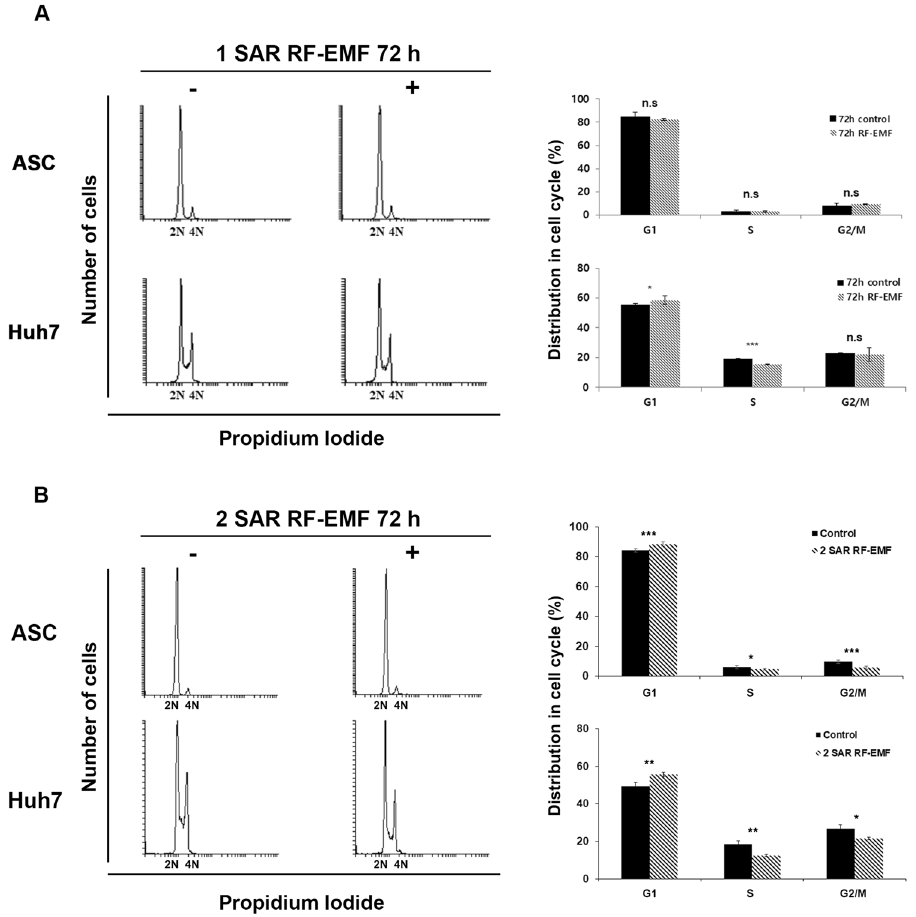
Figure 7. Continuous exposure to 1.7 GHz LTE RF-EMF induced cell cycle delay at G1 phase in ASCs and Huh7 cells. ( A–B ) ASC and Huh7 cells were exposed to 1.7 GHz RF-EMF for 72 h at 1 SAR ( A ) or 2 SAR ( B ). The DNA content of the 1.7 GHz RF-EMF-exposed and the unexposed sham control cells was analyzed by flow cytometry (BD Bioscience) after PI staining. 100,000 cells were counted for each experiment. The FACS results were analyzed using Flowing software 2 and the distribution of cells in each stage of the cell cycle was calculated from the FACS results shown in the left panel using Flowing software 2. P < 0.05 ( * ), P < 0.01( ** ), P < 0.001( *** ), and P > 0.05 (non-significant,